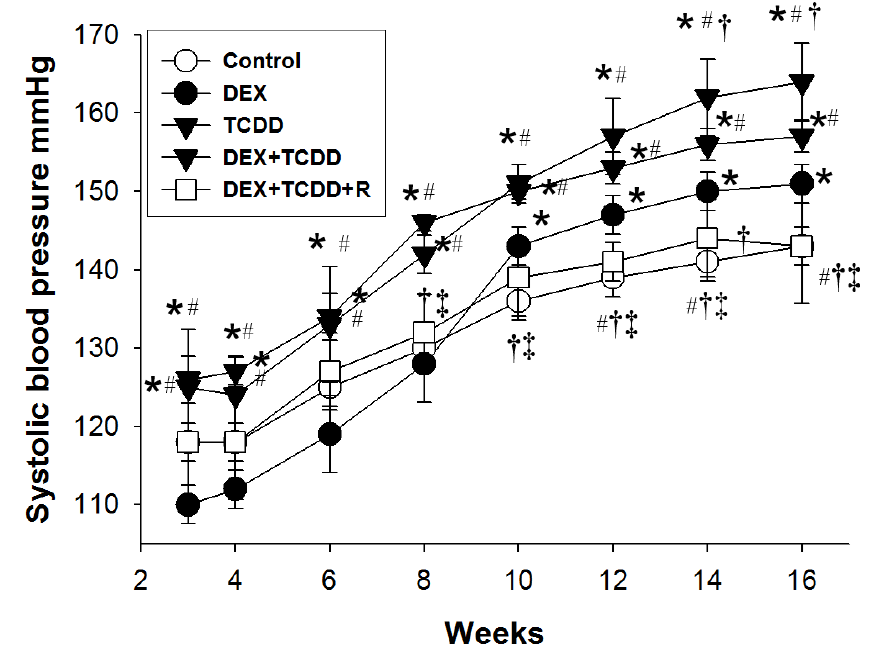
Figure 1. Effects of maternal 2,3,7,8-tetrachlorodibenzo-p-dioxin (TCDD), prenatal dexamethasone (DEX), and resveratrol (R) on systolic blood pressure (SBP) measured in male offspring at 3, 4, 6, 8, 10, 12, 14, and 16 weeks postnatally. Data were analyzed by one-way ANOVA followed by Dunnett’s C post hoc test. * p < 0.05 versus control group; # p < 0.05 versus DEX group; † p < 0.05 versus TCDD group; ‡ p < 0.05 versus DEX + TCDD group ( n = 7–8/group).